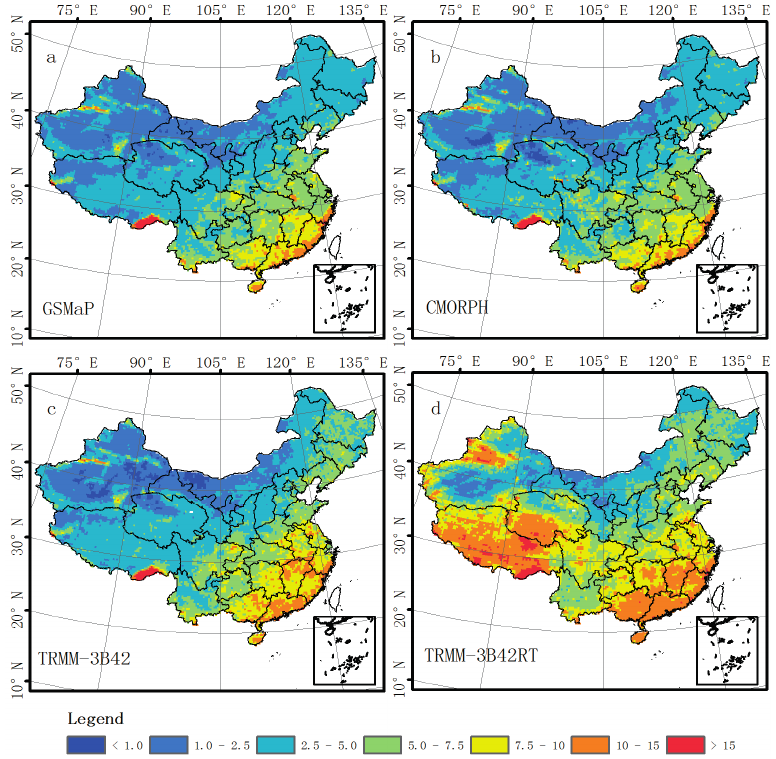
Figure 7. Distribution of RMSE over the Chinese Mainland from 2003 to 2006.